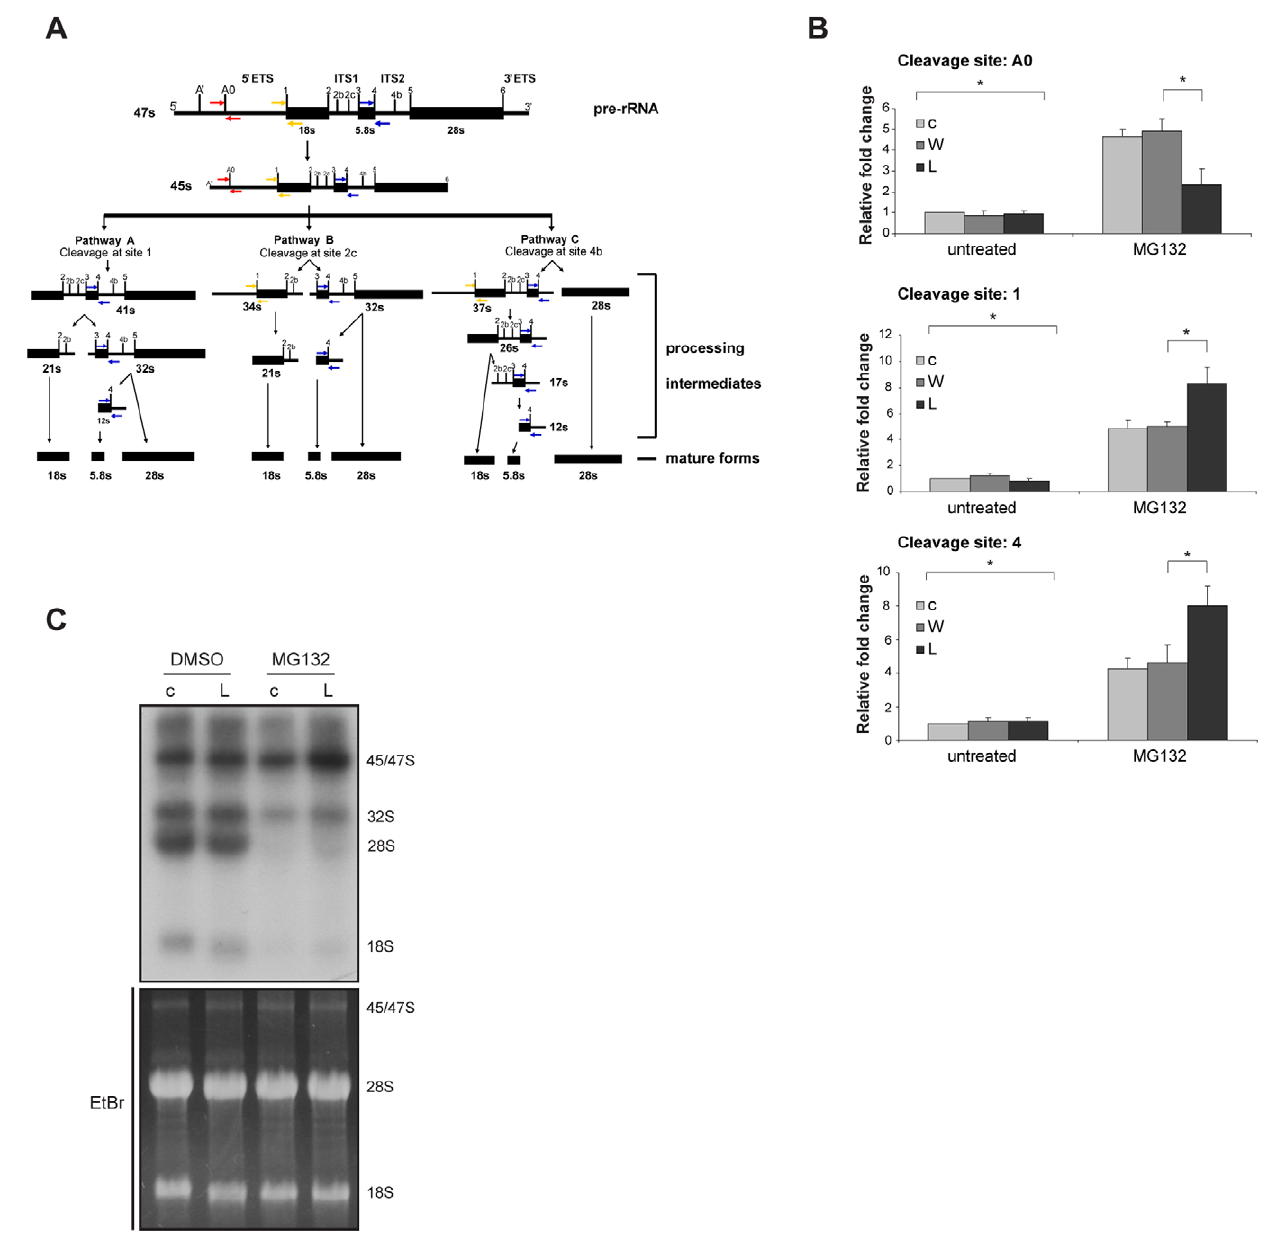
Figure 3. Processing of rRNA is altered in L166P overexpressing cells. (A) Schematic diagram showing pre-rRNA structure and processing steps. Positioning of A0, 1 and 4 cleavage sites on rRNA processing intermediates is shown. ETS, external transcribed spacer; ITS, internal transcribed spacer. (B) Analysis of steady-state levels of rRNA precursor and processing intermediates. SH-SY5Y cells stably expressing wt DJ-1 (W), L166P (L) and empty vector (c) were treated with Bars, 5 m M MG132 for 16 h, or left untreated. Total RNA was extracted and levels of pre-rRNA and processing intermediates were analyzed by qPCR with primers targeting A0 , 1 and 4 cleavage sites. Standard deviations are calculated on four replicas from two independent experiments. *, p , 0.05. (C) Analysis of rRNA processing by metabolic labeling. L166P (L) and control (c) cells were treated as in A. After treatment, cells were pulse-labeled with 32 P-orthophosphate for 1 h and chased with cold medium for 3 h. RNA was extracted and equal quantities were separated on denaturing agarose gel. Nascent rRNA was visualized by autoradiography after gel drying (upper panel). rRNA processing intermediates and mature forms are indicated on the right. Loading was verified with ethidium bromide staining (lower panel).